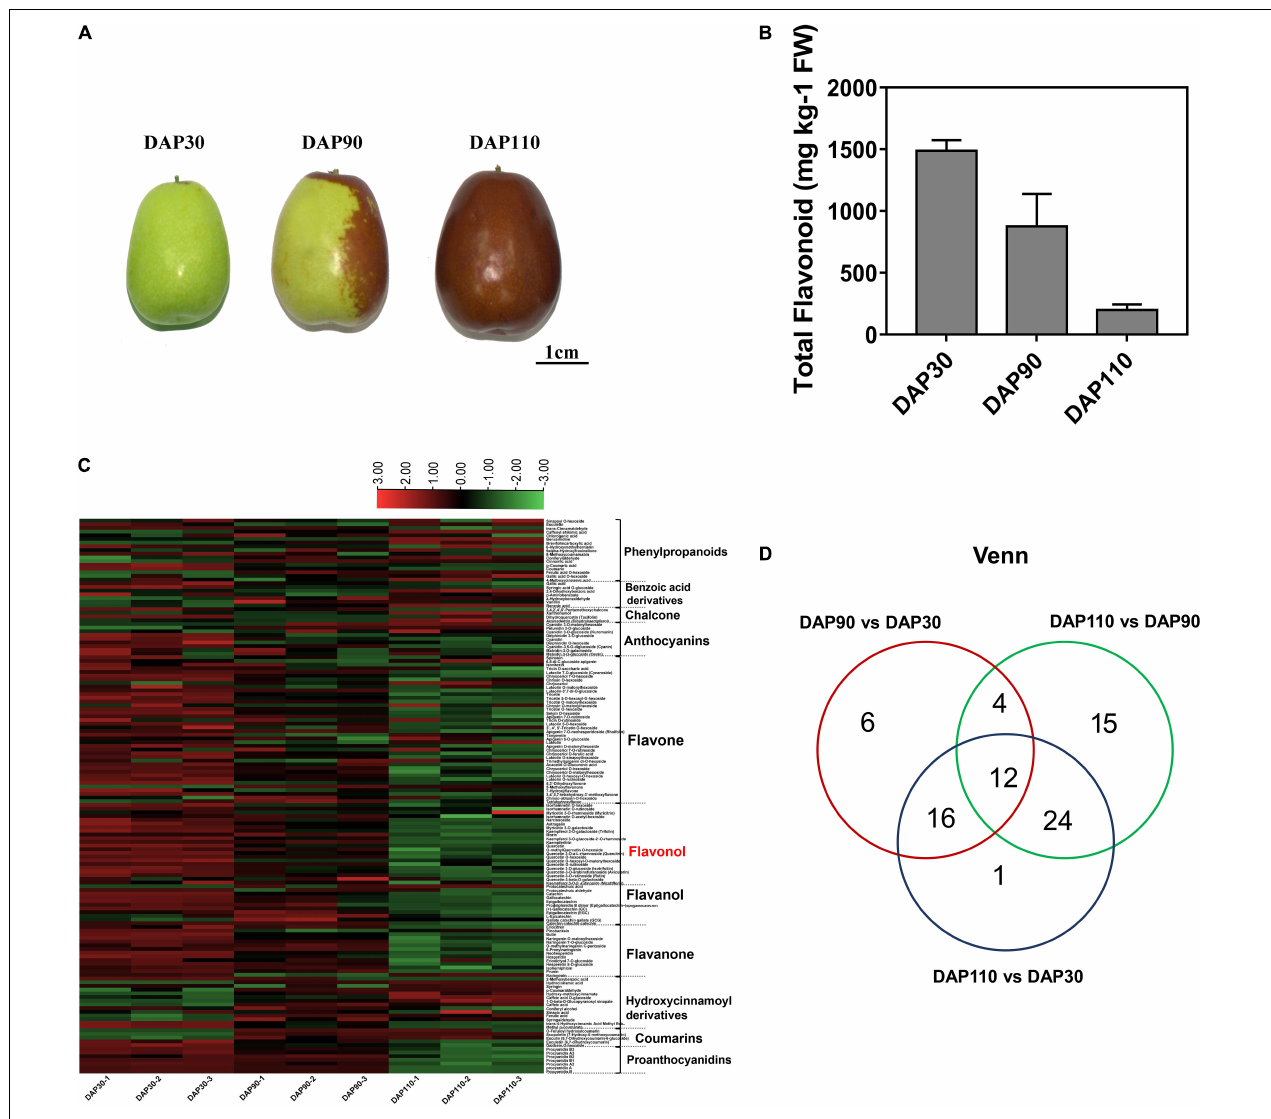
FIGURE 1 | Flavonoid contents of jujube fruits at three developmental stages. (A) ‘Junzao’ jujube fruit at three developmental stages. (B) Total flavonoid content of jujube fruit skins at three developmental stages. (C) Heat map of differentially abundant metabolites in jujube fruit skins at three developmental stages. (D)